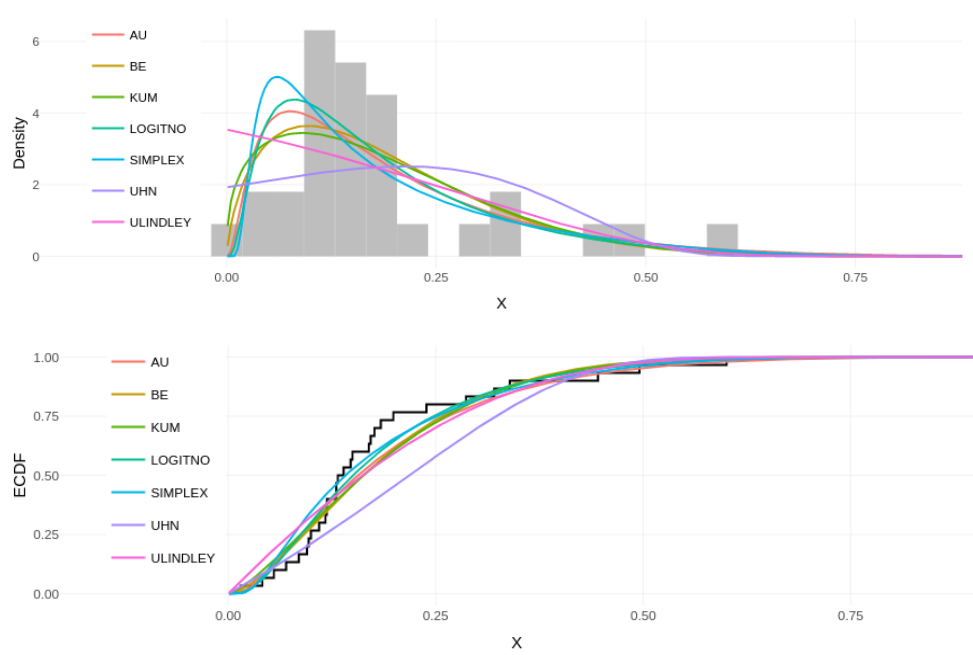
Figure 4. Estimated densities superimposed to the histogram ( top-chart ), and estimated CDFs superimposed to the ECDF ( bottom-chart ) (Chilean inflation